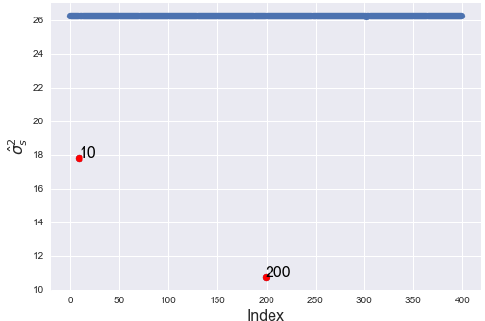
Figure 8. Index plot of σ 2 s for the simulated